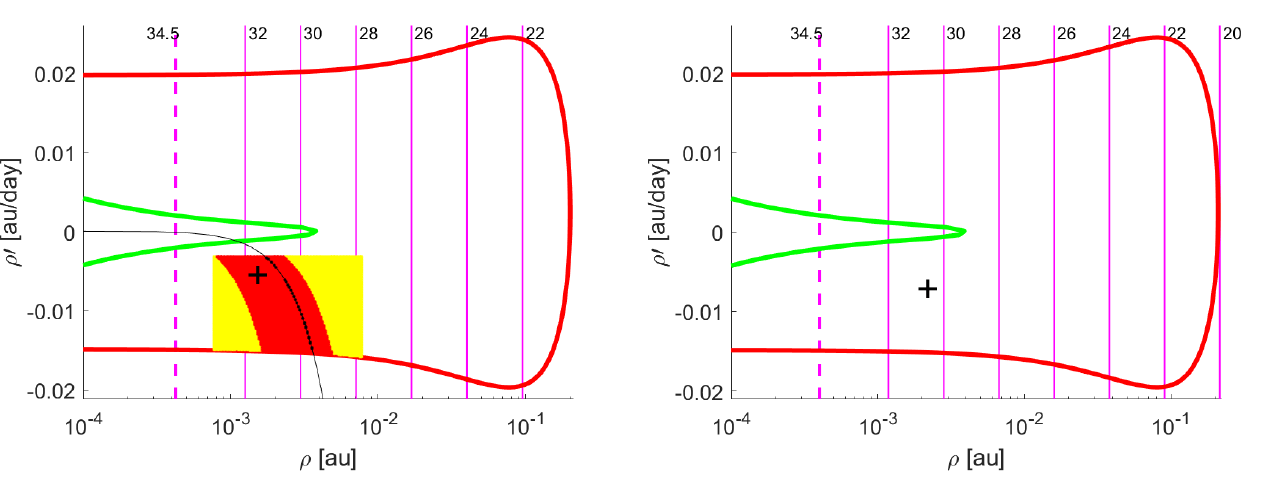
Figure 4. Tool 1 tested on the four tracklets of observations belonging to asteroid 2018LA. From top left to bottom right, runs for 3, 11, 12 and 14